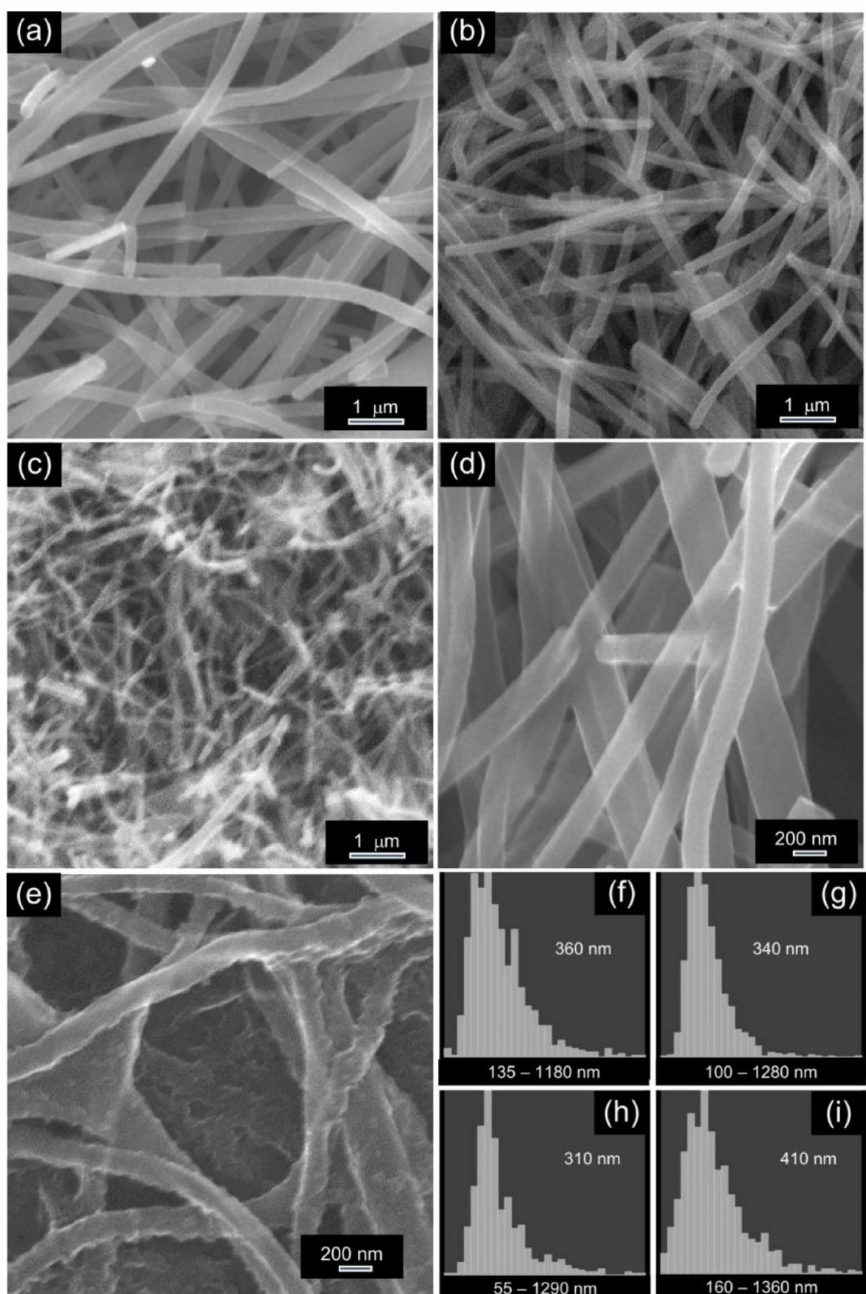
Figure 2. ( a – e ) Morphology of the fibrous membranes and ( f – i ) distributions of the fibre diameters. The shown SEM images refer to membranes ( a ) P1:0-500, ( b , d ) P1:0-800, ( c ) P2:1-650 and ( e ) P6:1-650. Histograms refer to samples ( f ) P1:0-500, ( g ) P1:0-650, ( h ) P1:0-800 and ( i ) P2:1-650 (the diameter distribution centre value is